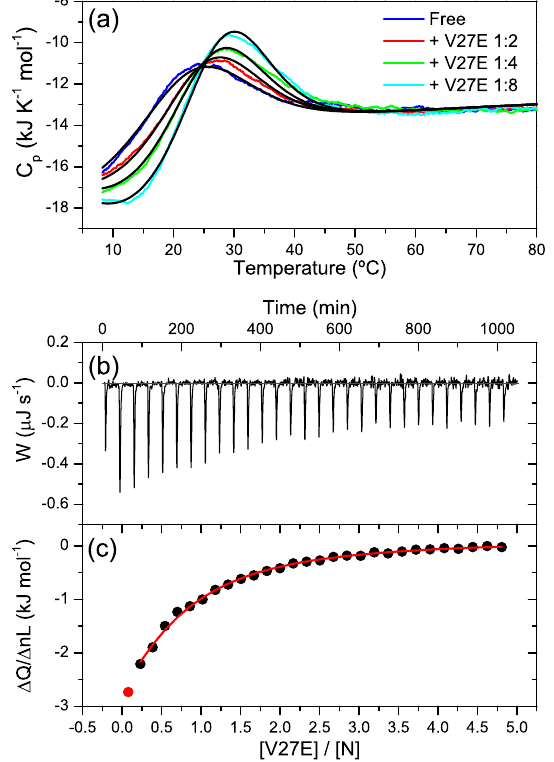
Figure 9. Binding of the HR2 V27E peptide to the CoVS-HR1-N protein. ( a ) DSC thermograms of CoVS-HR1-N at pH 7.4 in the presence of the V27E peptide at varying molar ratios. The protein concentration was 30 µ M in all experiments. The black lines represent the global fitting of the curves using a model of two-state unfolding coupled with binding. ( b ) ITC thermogram of 30 µ M of CoVS- HR1-N titrated with V27E peptide at 25 ◦ C and pH 7.4. ( c ) Binding isotherm calculated from the thermogram of ( b ). The symbols represent the binding heats normalized per mole of added peptide. The red line represents the fitting using a model of n independent and identical binding